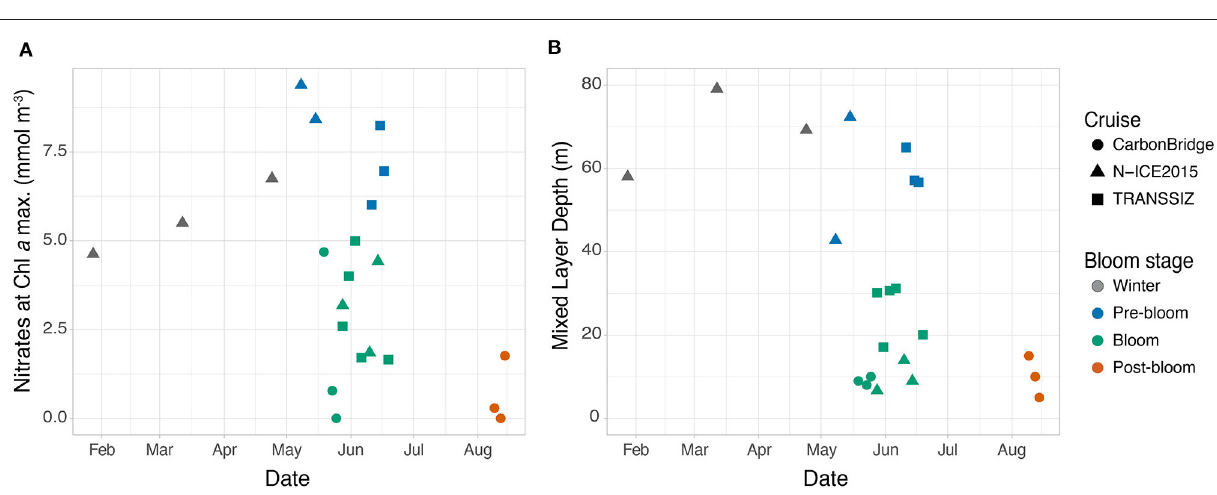
FIGURE 3 | Seasonal development of (A) nitrate concentrations at the Chl a maximum depth or the average of the upper 10m of the water column (when no Chl a maximum was present), and (B) of the depth of the mixed layer. Note that for N-ICE2015 and TRANSSIZ, the dates are from 2015, while for CarbonBridge, the dates are from